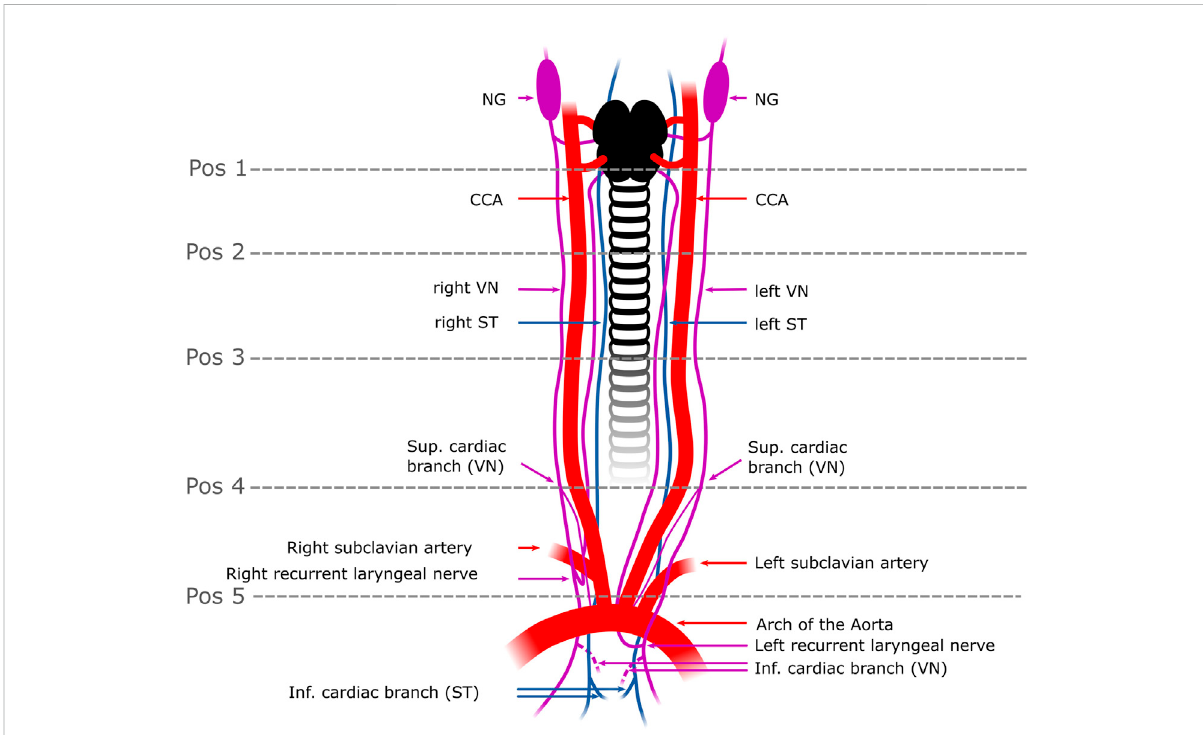
FIGURE 1 Schematicoverviewofthesurgicalwindowinapig.TheVNcanbedistinguishedfromtheSTbyidenti fi cationoftheNG.Insomeindividuals,the two nerves were observed to merge or split at the cervical level. In rabbits, the VN and the ST were travelling individually next to each other to the cardiac plexus. Five anatomical positions (pos 1-pos 5) were de fi ned from cranial to caudal at which the fascicle number and nerve areas were measured. The superior CB was the branch used in this study (one superior CB per nerve) and harvested right above the level of the subclavian artery (pos.5); the inferior CB (indicated as dashed lines) was not used in this study since its anatomical position in the epicardial fat is surgically less feasible for selective stimulation than the superior CB. Pos. 1-3 label the upper to the mid-cervical level. Pos. 4 indicates the cardiac branching point of the superior CB. NG, nodose ganglion; CCA, common carotid artery; VN, Vagus Nerve; ST, Sympathetic trunk; Pos, position; sup. cardiac branch, superior cardiac branch; inf. cardiac branch, inferior cardiac